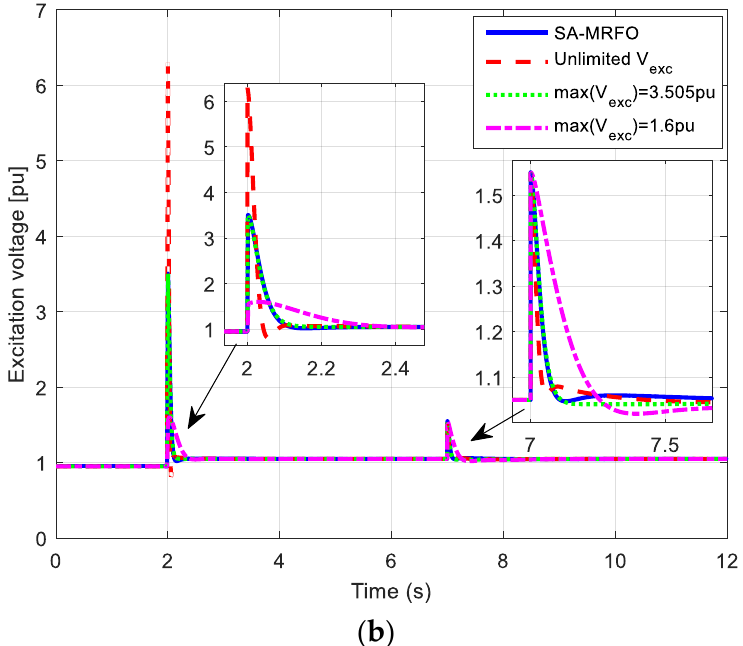
Figure 12. Investigation of excitation voltage limitation: ( a ) generator voltage response and ( b ) excitation voltage response for regulator parameters shown in Table 7.